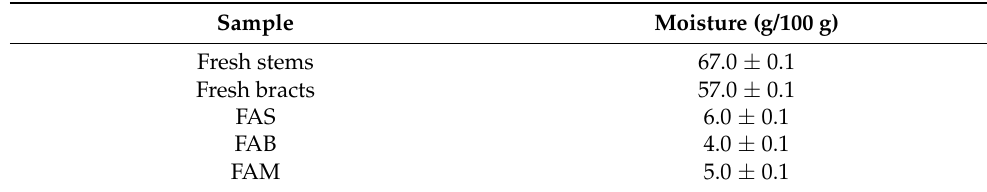
Table 1. Moisture content of fresh artichoke stems and bracts and of the corresponding